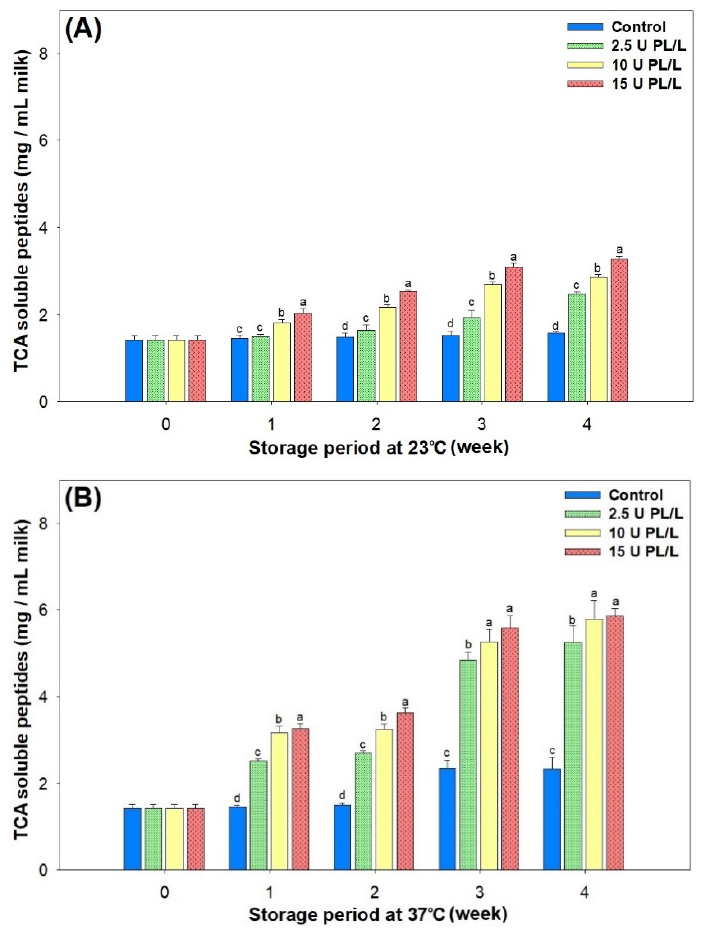
Figure 3. Changes in TCA soluble peptide content of UHT skim milk samples containing 2.5, 10, and 15 U PL/L during storage at ( A ) 23 °C and ( B ) 37 °C. a–d Different letters indicate significant difference within the same storage period ( p < 0.05). TCA, trichloroacetic acid; UHT, ultra-high temperature; PL, plasmin.